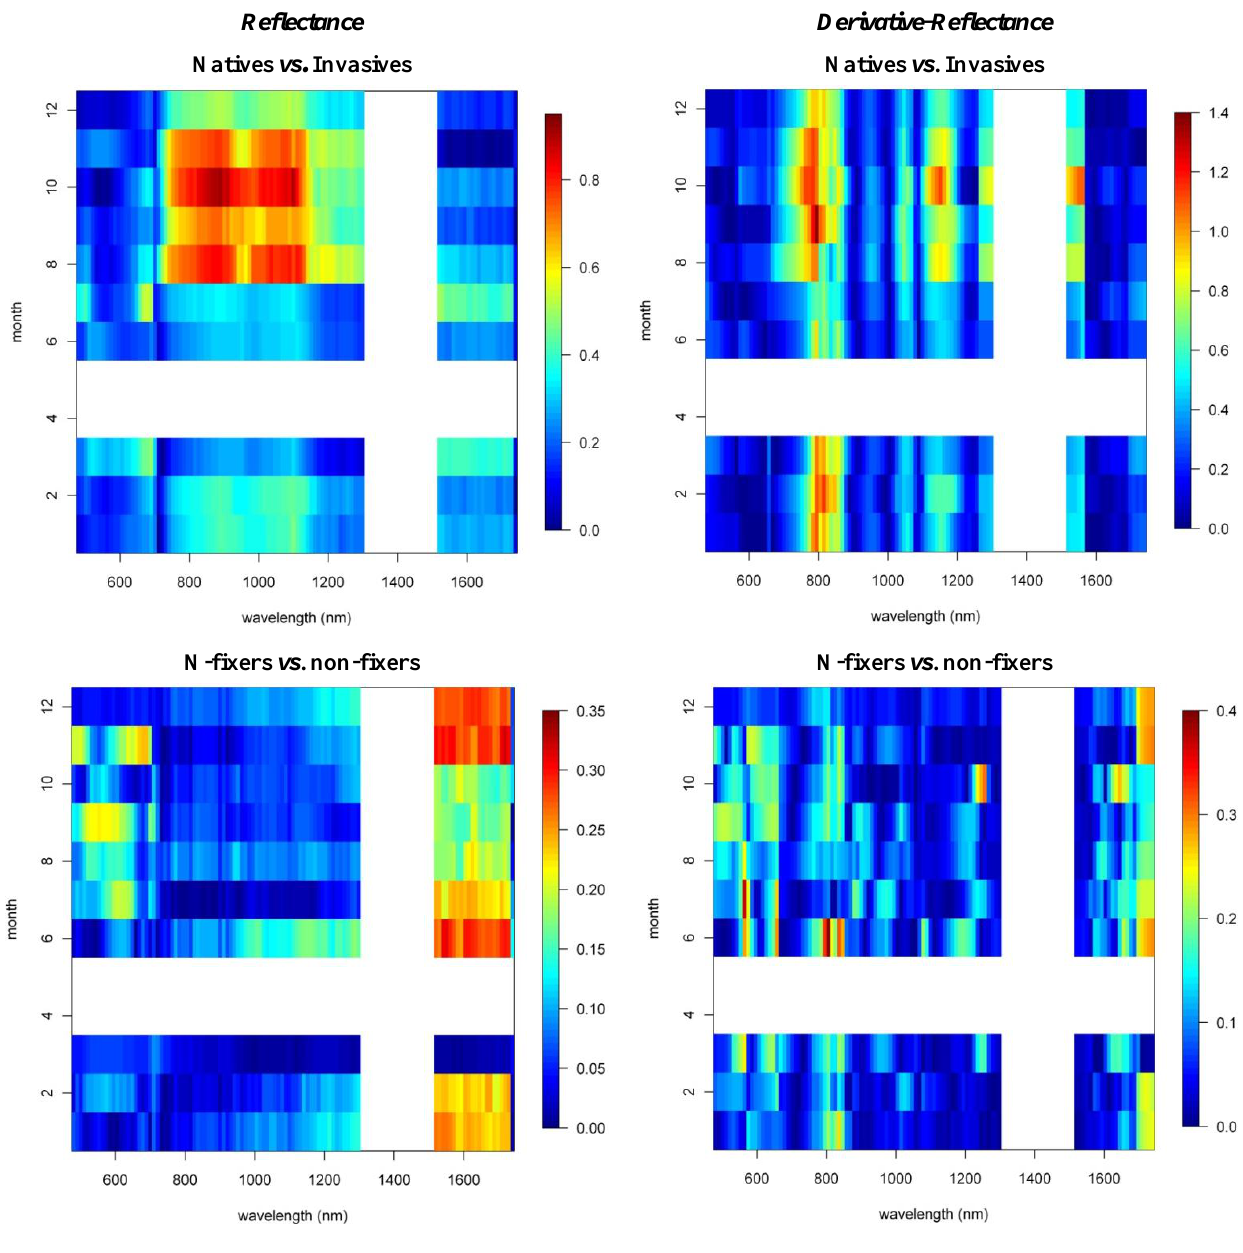
Figure 8. Reflectance and 1st-d reflectance spectro-temporal Separability Index charts for the comparisons of native vs . invasive tree